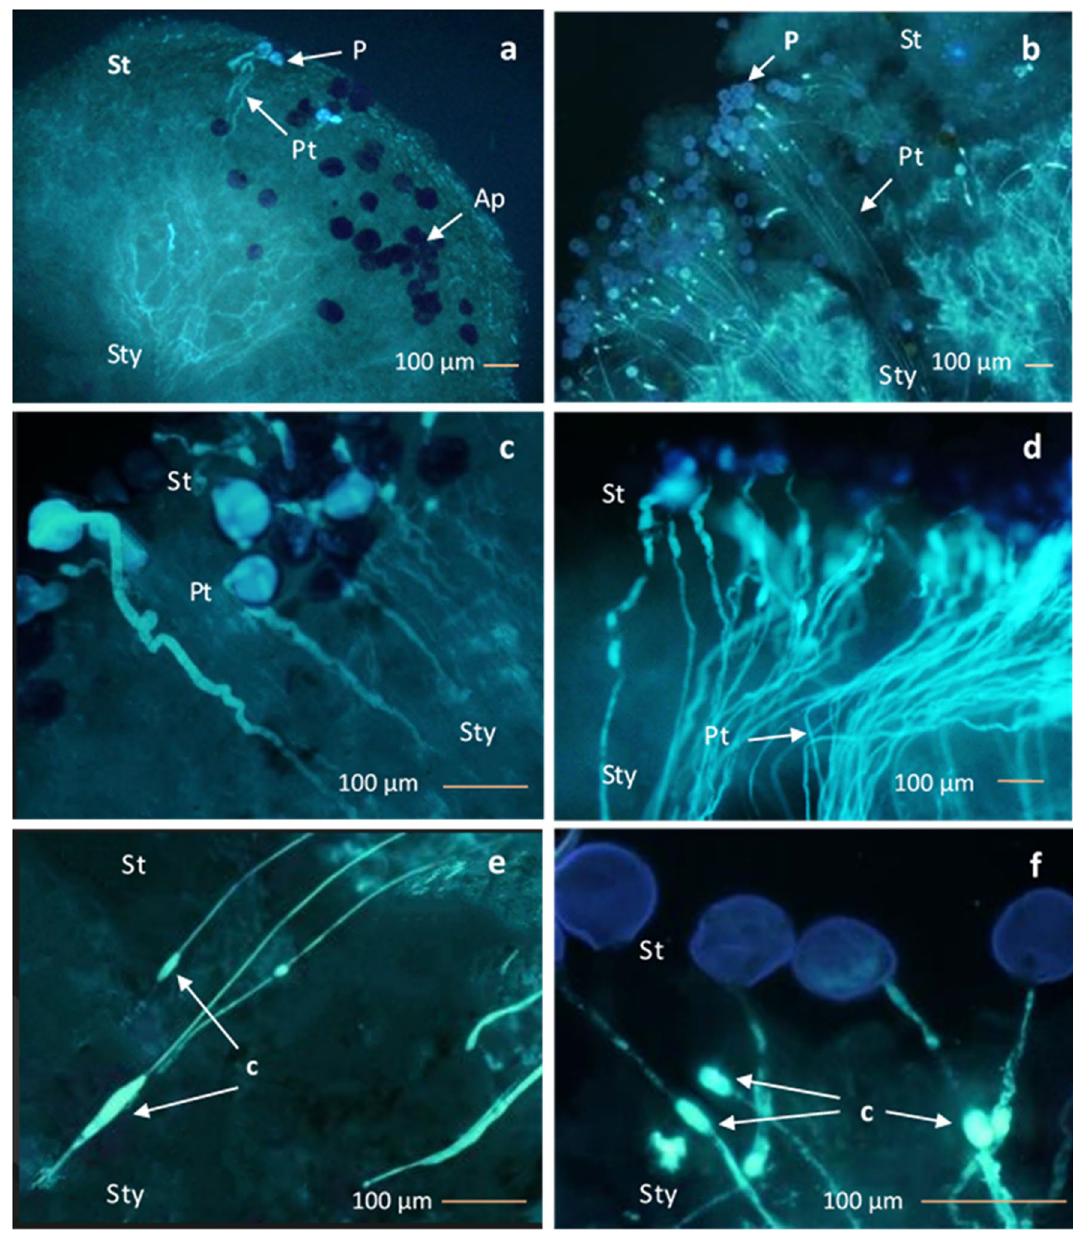
Figure 5. Fluorescence micrographs showing pollen tube growth and behaviour of pollen grains on pistil in two hand-pollinated crosses; triploid × triploid cross (a,c,e) and triploid × diploid cross (b,d,f) ; (a) pollen grains (P), pollen tube (Pt) and abnormal pollen grains which were not stained (Ap) in the upper surface of stigma (St), (c) short twisted thick pollen tube (Pt) developed from top of the stigma (St), (e) irregular callose plugs developed in the pollen tubes; (b) stained pollen grains (P) and pollen tubes (Pt) in the pistil, (d) long thin pollen tubes, (f) regular callose plugs in the pollen hand-pollination study, we did not find a significant difference in pollen germination with genotype. This is likely to be because honey bees visit both genotypes while foraging 17,40 , which will have resulted in a number of viable pollen grains from diploids being deposited on our stigmas even if a bee had moved directly from a triploid male flower. We also found that the proportion of bee transferred pollen to germinate to the stigma was higher for both genotypes compared to our hand-pollinations. The simplest explanation is that the honey bees were more effective pollinators 41 , however it is possible that a greater number of pollen grains from diploids germinated as the result of recipient interaction with pollen from triploids in the stigma, a mechanism has previously been considered for heterospecific pollen (e.g., a heard effect 42 ). The potential for interaction (neutral/positive/nega- tive) among the pollen genotypes was not assessed in the current study, but the morphological descriptions we provide will permit other researchers to conduct this comparison.